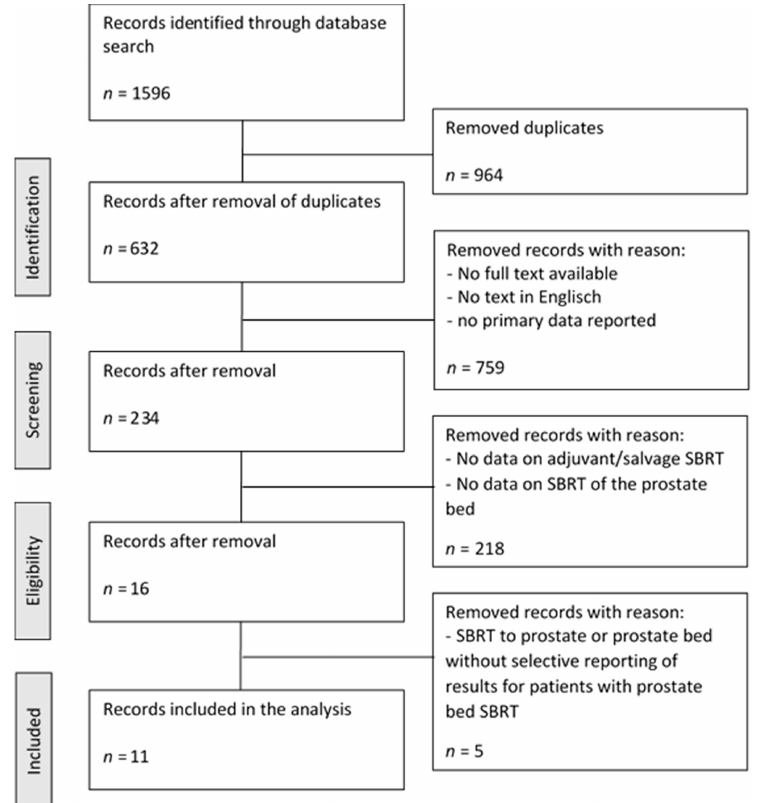
Figure 1. Paper selection process.